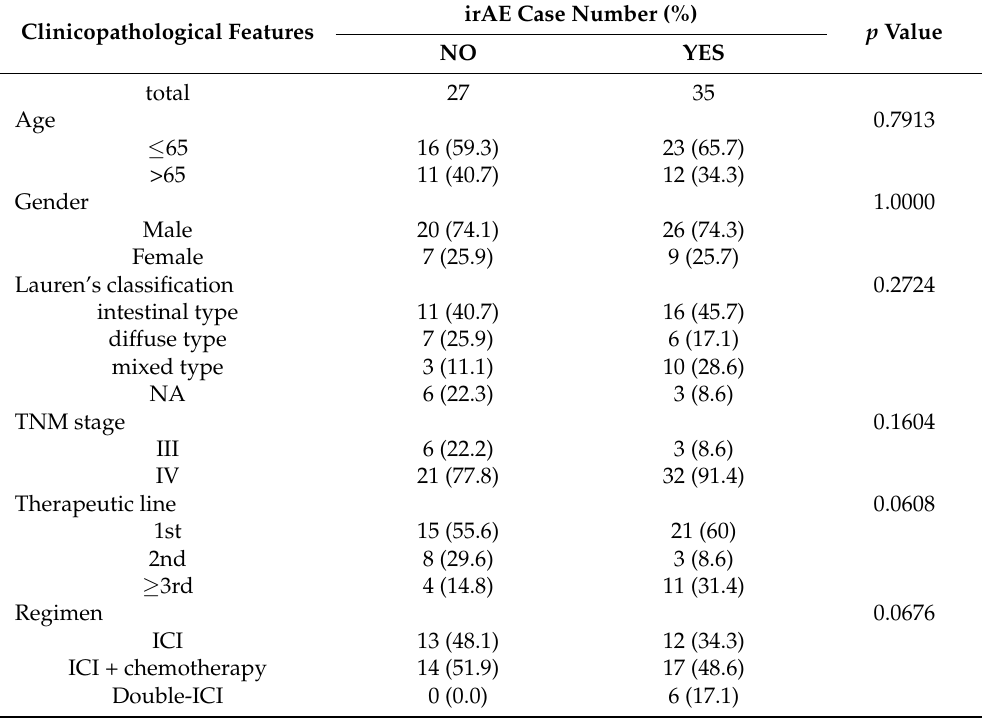
Table 2. Correlation of irAE with clinicopathological features in discovery cohort (n = 62). Clinicopathological